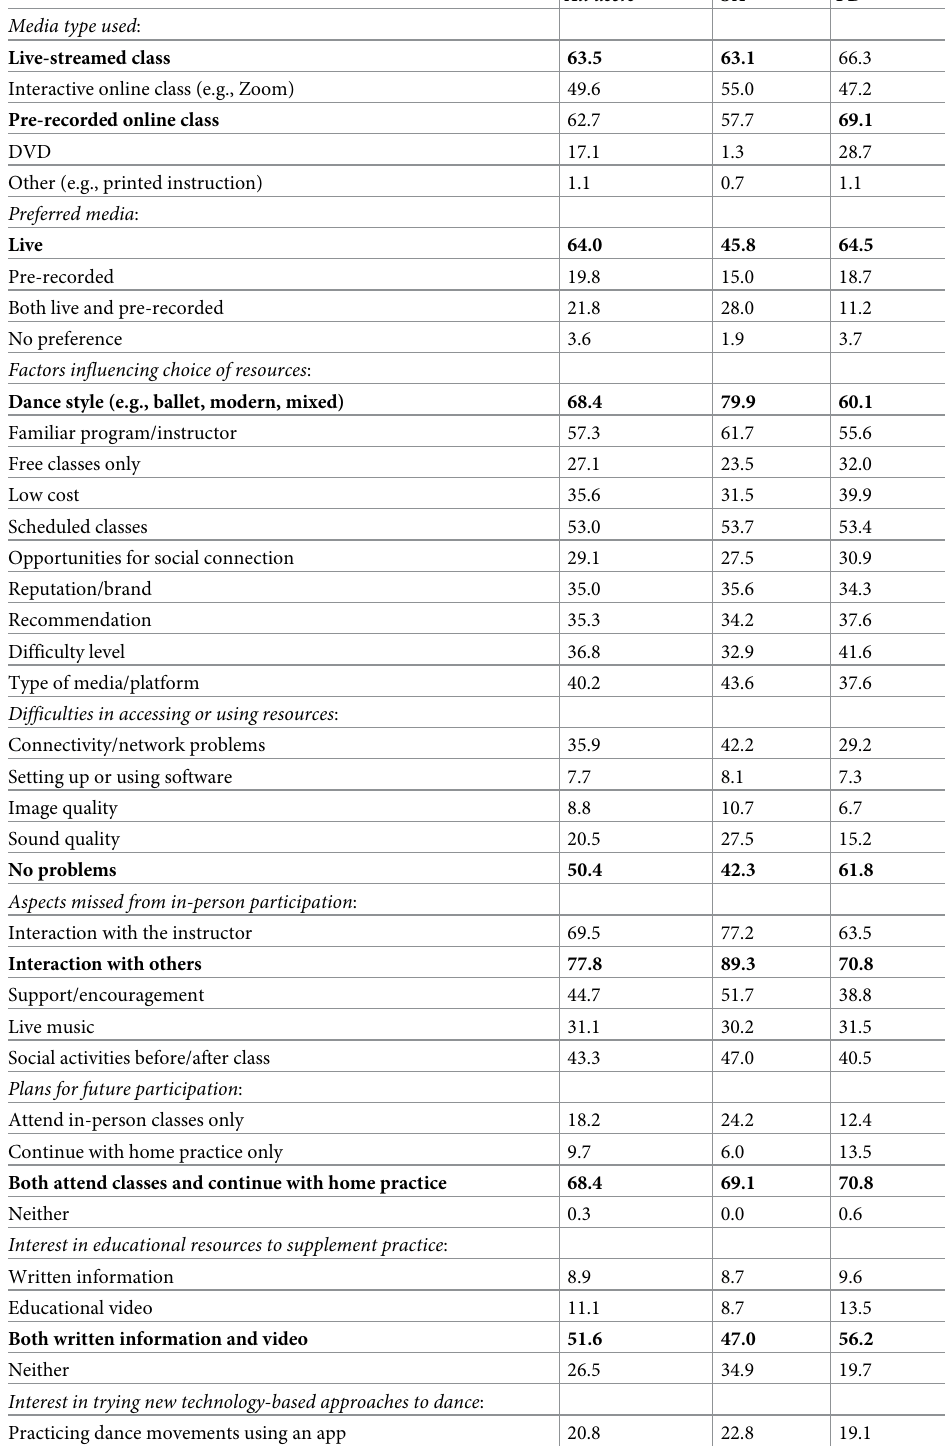
Table 2. Survey responses summarised as percentages of participants endorsing each item presented separately for all users of at-home dance programs, older adults (OA), and individuals with Parkinson’s disease (PD). The most frequent responses to each item are indicated in bold for each